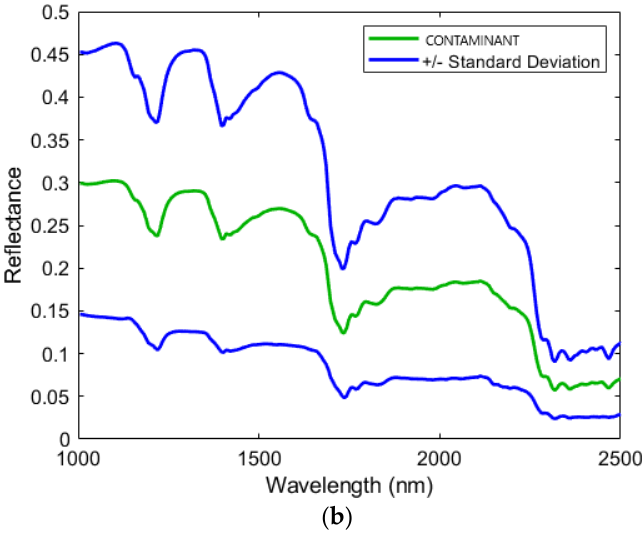
Figure 3. Average raw spectra and standard deviation of PET ( a ) and contaminant ( b ) classes in the SWIR range.